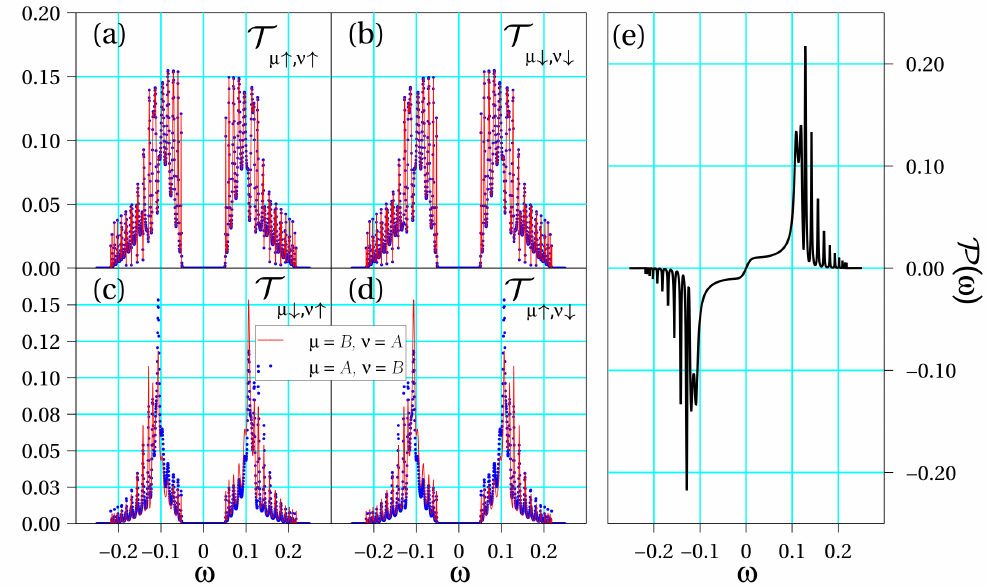
Figure 3. Transport coefficients obtained for a quasi-symmetric molecules with the same parameters as in Figure 2 but t A = − t B = 0.1 and λ A = λ B = 0.01. Transmission coefficients ( a ) T µ ↑ , ν ↑ ( ω ) ; ( b )